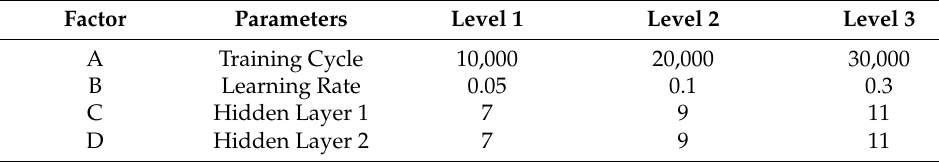
Figure 13. Comparison diagram for loss value in the training set and the verification set. Table 12. Artificial neural network factors and level